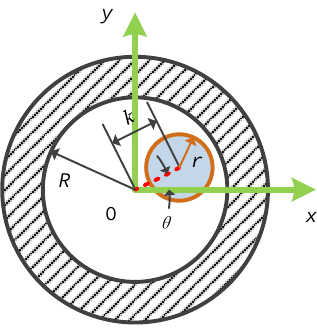
Figure 1. The geometrical representation of clearance